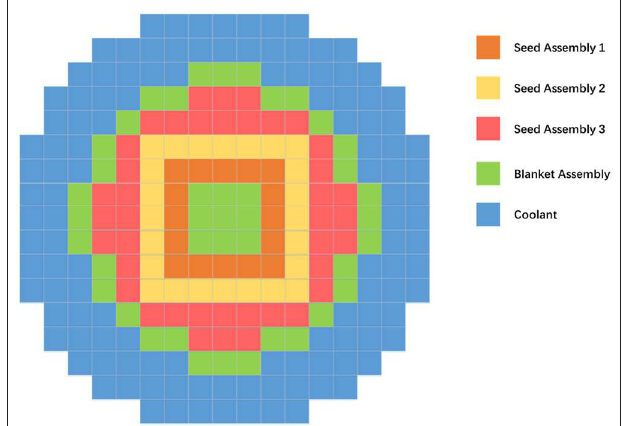
FIGURE 4 | k eff and CR variations of RMSMR-Th and